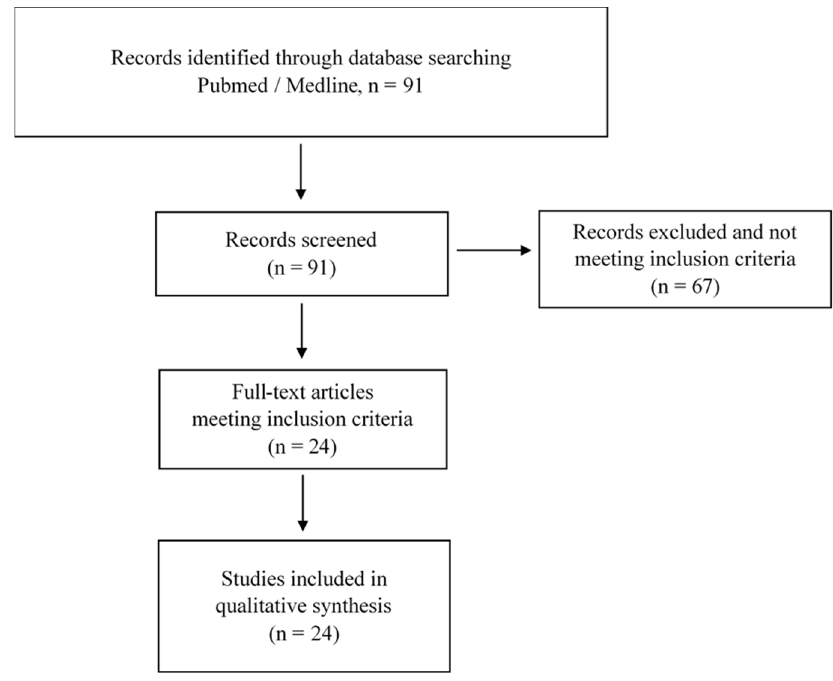
Figure 1. Flow chart of the published studies selection process of the review.